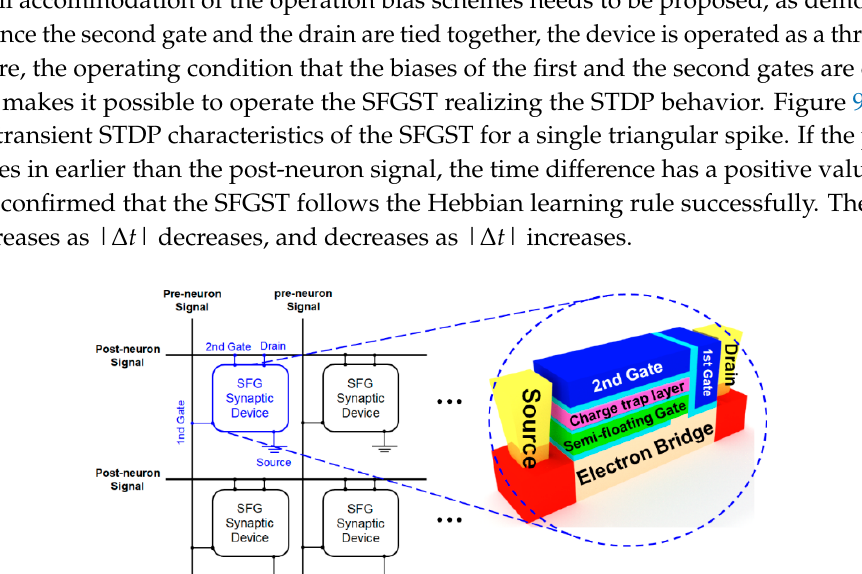
Figure 9. Simulated spike-timing-dependent plasticity (STDP) characteristics of the SFGST after a single triangular spike. Following the Hebbian learning rule [16], the synaptic change is determined by Δ t . This can be also verified by Figure 10, which shows the variation in the threshold voltage by the potentiated or depressed SFG. As briefly mentioned earlier, the variation in the threshold voltage becomes larger as | Δ t | gets larger. Finally, Figure 11 shows the simulated learning operations as a function of number of potentiation pulses. From the results demonstrating that the given pre- and post-neuron signals potentiate the SFGST making the distinction between STP and LTP, it is confirmed that the designed SFGST is fully functional as a synaptic device.